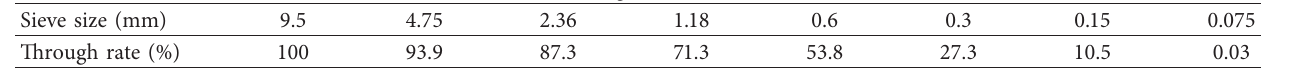
Table 1: Screening results of coral sand.